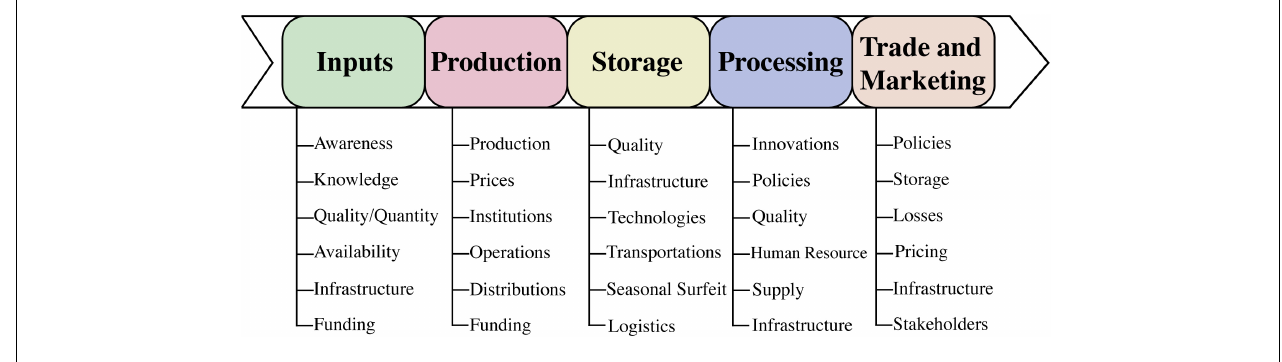
FIGURE 7 | Role of financial services to address the issues of food security